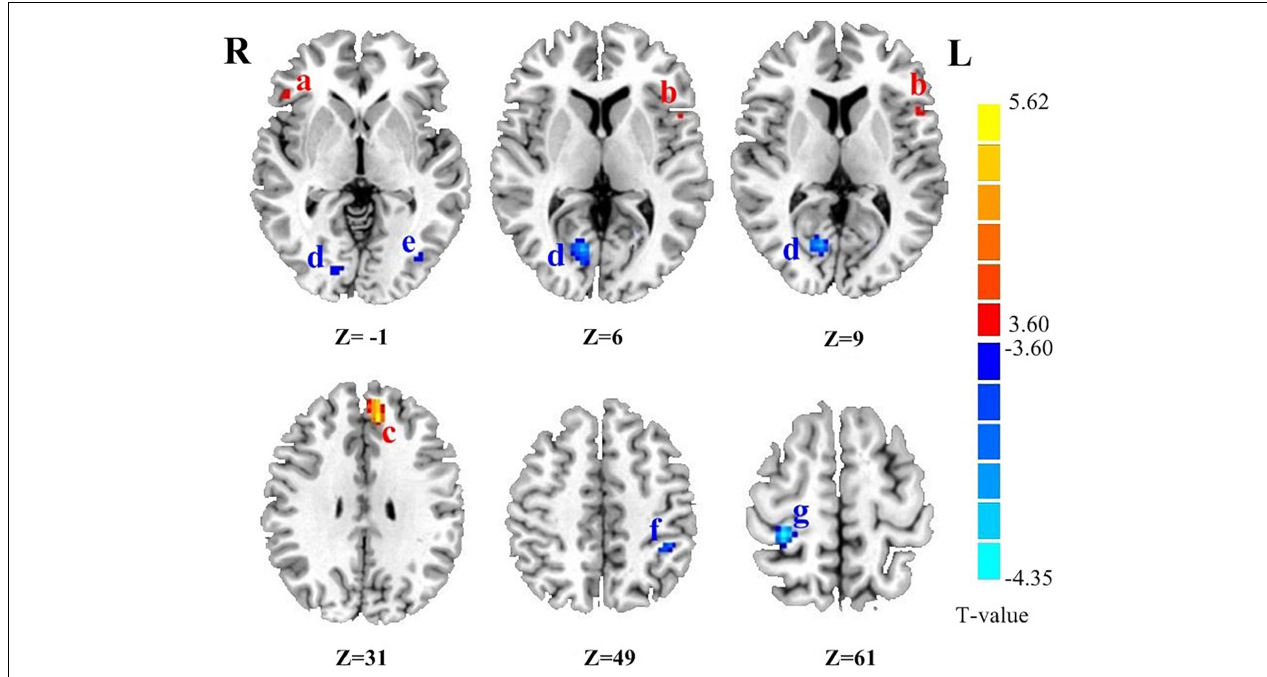
FIGURE 1 | The brain regions with abnormal DC value in PD patients. (a) Right inferior frontal gyrus. (b) Left precentral gyrus. (c) Left medial frontal gyrus. (d) Right occipital lobe. (e) Left inferior temporal lobe gyrus. (f) Left inferior parietal lobule. (g) Right postcentral gyrus. Z is the coordinates of the Montreal Neurological Institute. The color scale indicates the magnitudes of T